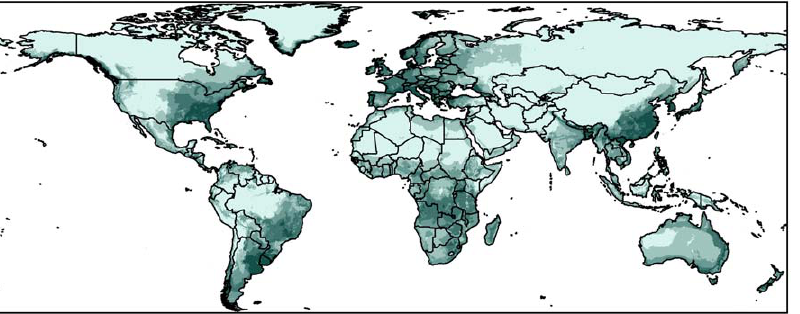
Figure 5. Niche models based on Dataset II and transferred worldwide using Maxent. Dark green color represents high suitability, light green indicates low suitability.